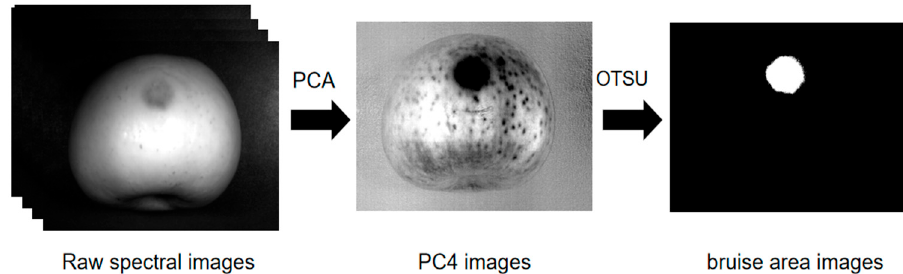
Figure 2. Bruise area extraction.